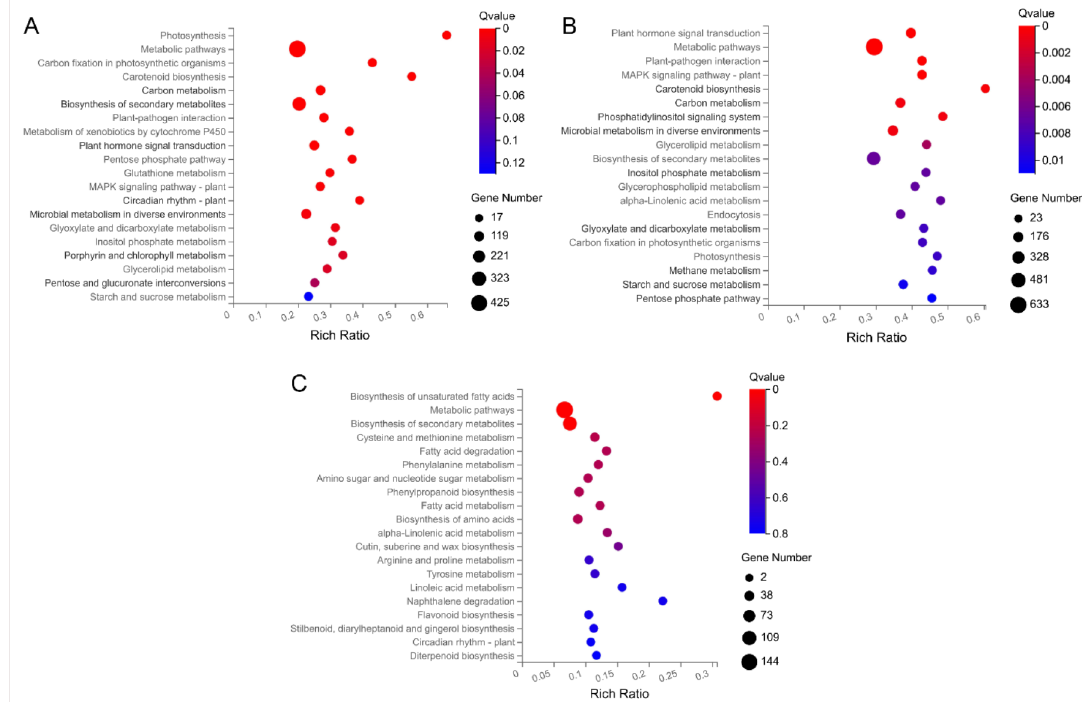
Figure 5. Bubble chart of KEGG pathway enrichment. ( A ) KEGG pathways enriched with upregulated DEGs from the MM_1-vs-MM_2 comparison. ( B ) KEGG pathways enriched with upregulated DEGs from the 20965_1-vs-20965_2 comparison. ( C ) KEGG pathways enriched with upregulated DEGs from the MM_2-vs-20965_2 comparison. The sizes of the bubbles indicate the number of genes enriched in the KEGG pathway. The color of the bubble represents the Qvalue. The rich factor is the ratio of differentially expressed gene numbers annotated in this pathway term to all gene numbers annotated in this pathway term. The greater is the rich factor, the greater is the degree of pathway